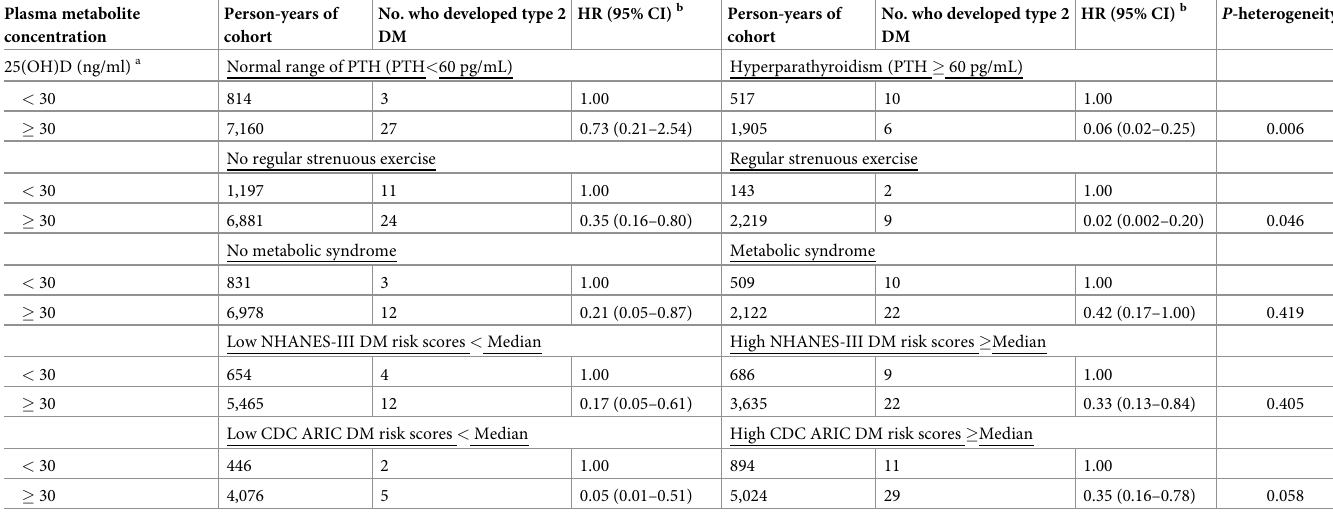
Table 6. Hazard ratios with 95% confidence intervals of type 2 diabetes mellitus (DM) incidence by plasma 25(OH)D levels after stratification for PTH levels, regu- lar strenuous exercise, metabolic syndrome, and DM risk scores. Plasma metabolite